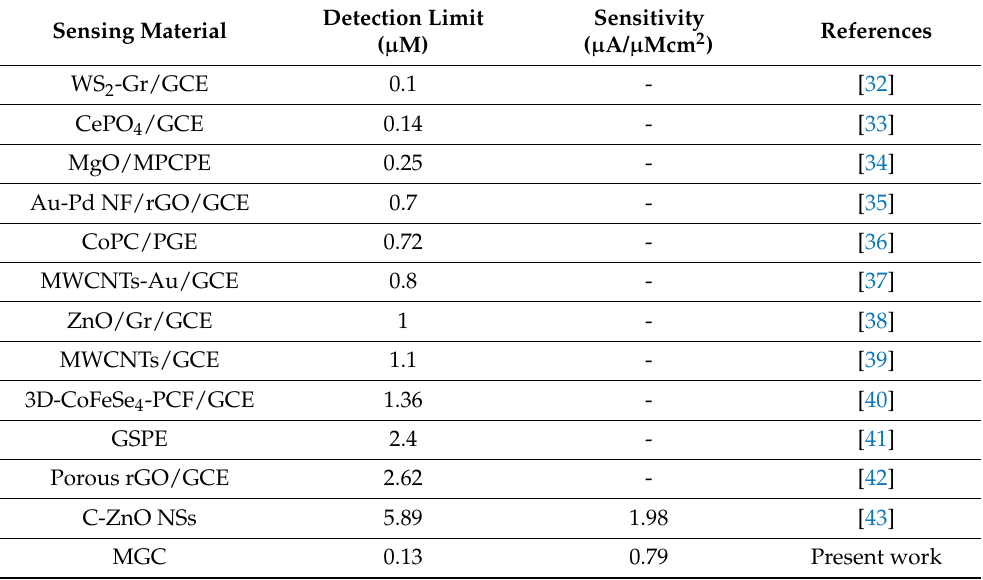
Table 1. Comparison of the sensitivity and LoD of the MGC against published literature [32–43]. Sensing